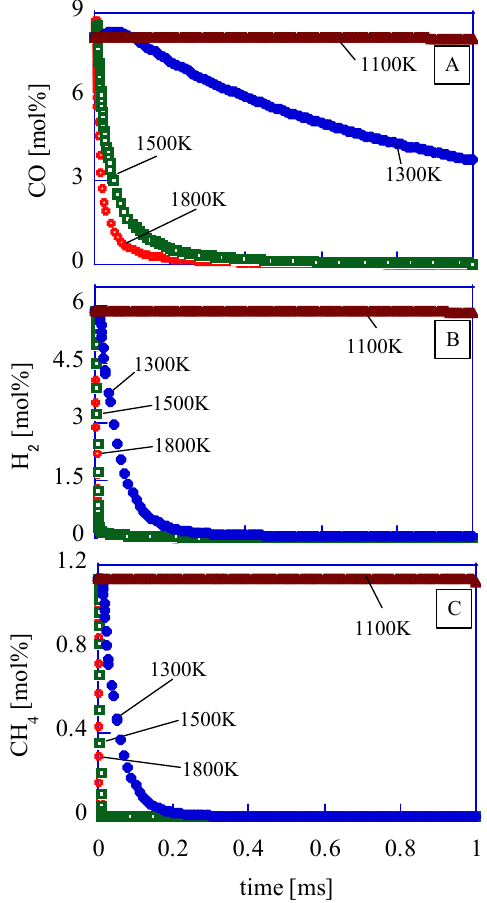
Figure 8. Time histories of CO, H 2 , and CH 4 in the chamber (calculated under constant pressure as